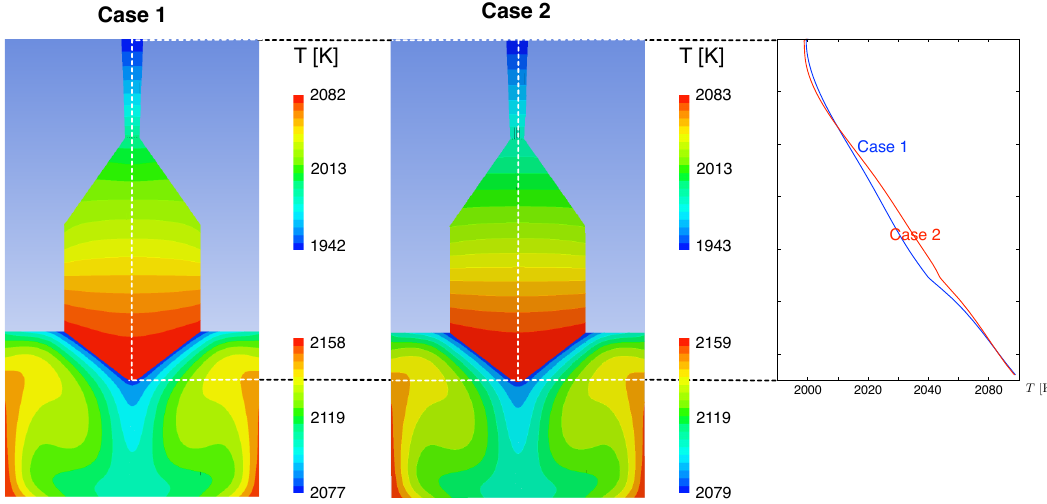
Figure 5. Temperature fields in melt, crystal, and seed for the two cases of different growth directions, as observed by 3D calculations with Ansys-cfx. The temperature profile at the center of the crystal is plotted on the right-hand side. Please note that the temperature scales for melt and crystal are given seperately to ensure a more detailed view. Because the temperature varies slightly along the crystal–melt interface, the minimum temperature in the melt and the maximum one in crystal are not identical but